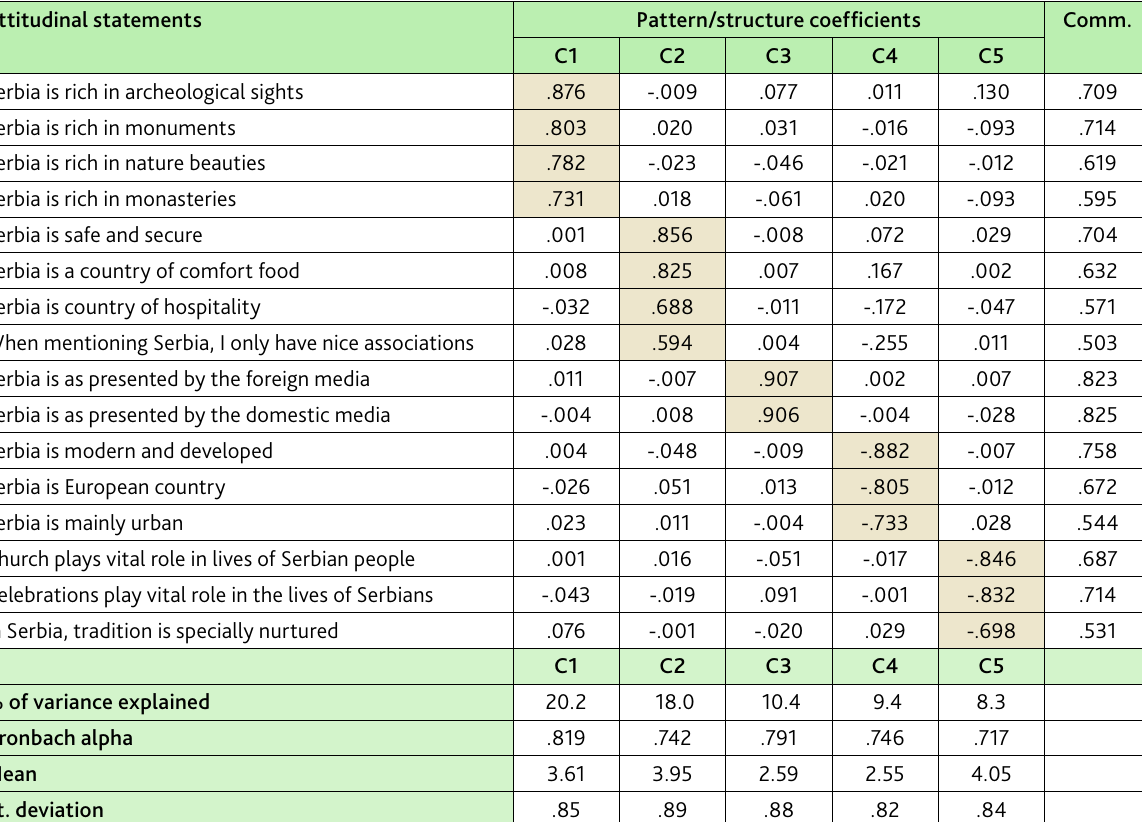
Table 6. Serbia brand identity Slovenian perception – rotated component matrix for PCA with Oblimin rotation for 5 factor